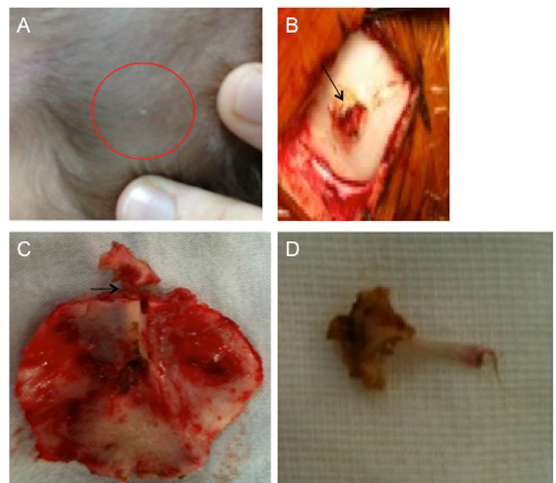
Figure 2. A Photograph depicting a small skin pinhole over the occipital region, in keeping with a dermal sinus tract. Intraoperative photographs show; B the dermal sinus tract associated with a bony erosion (black arrow); C craniotomy along with the tract (black arrow) and, D after its excision.